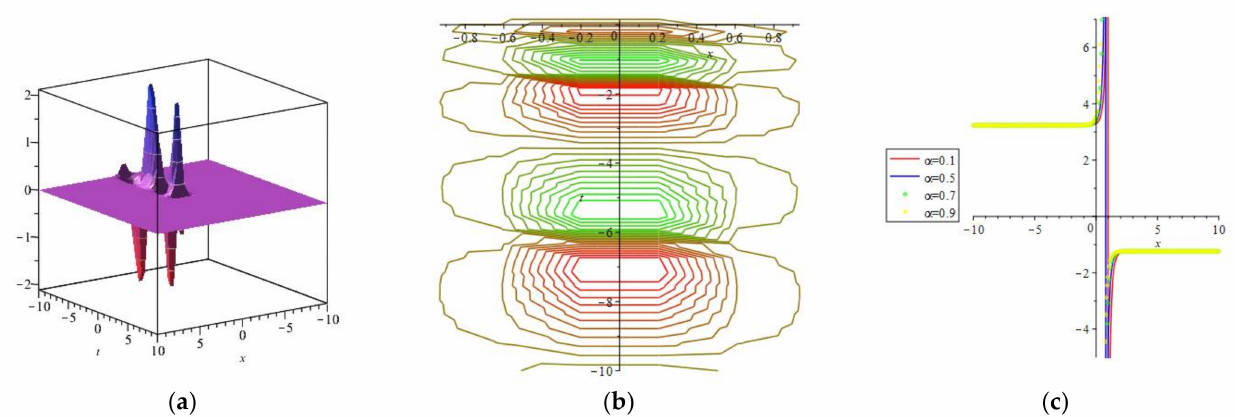
Figure 3. The graphical representation of the solution λ 22 ( χ ) : ( a ) 3D shape, ( b ) contour plot, and ( c ) 2D graph.